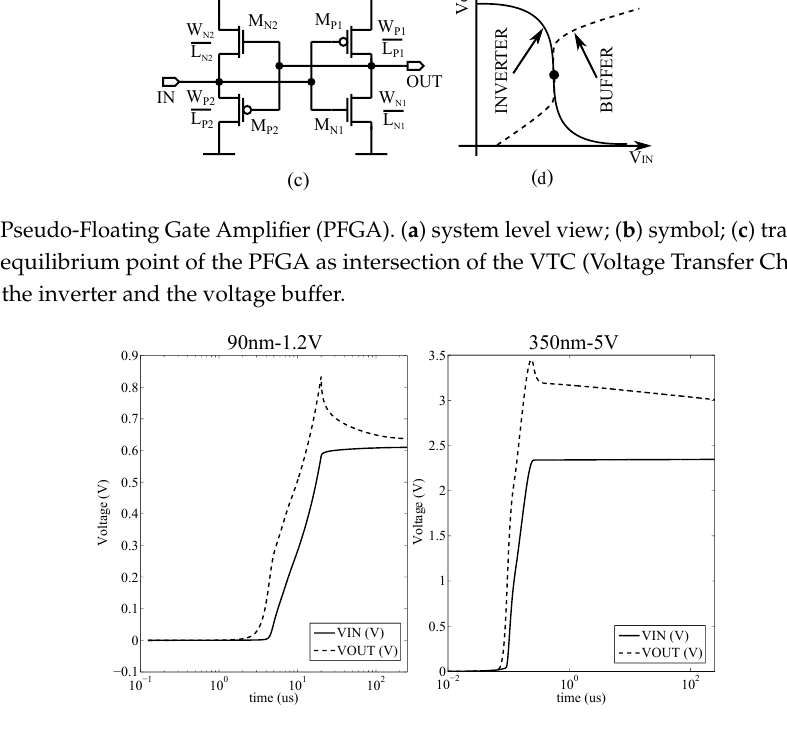
Figure 4. Comparison between the Predictive Technology Model (PTM-90nm) model ( V DD = 1.2 V) and Austria Mikro Systeme (AMS-350nm) model ( V DD = 5 V) in terms of initial transient time to approach to the